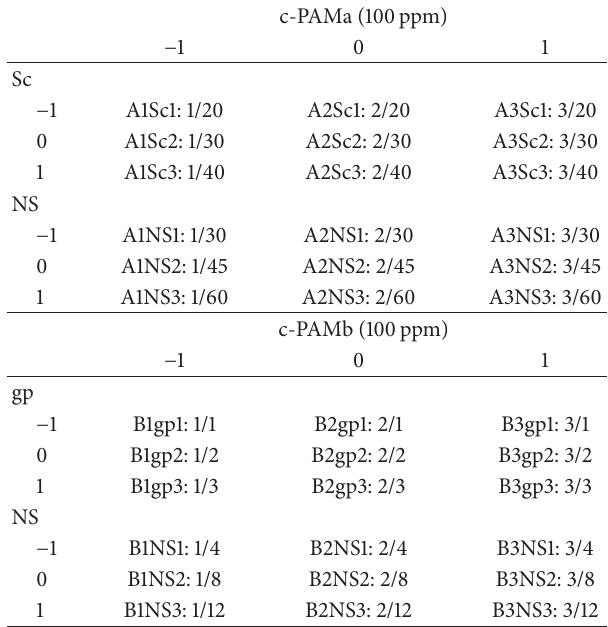
Table 1: Codes for the dual-chemical combinations and their respective dosing